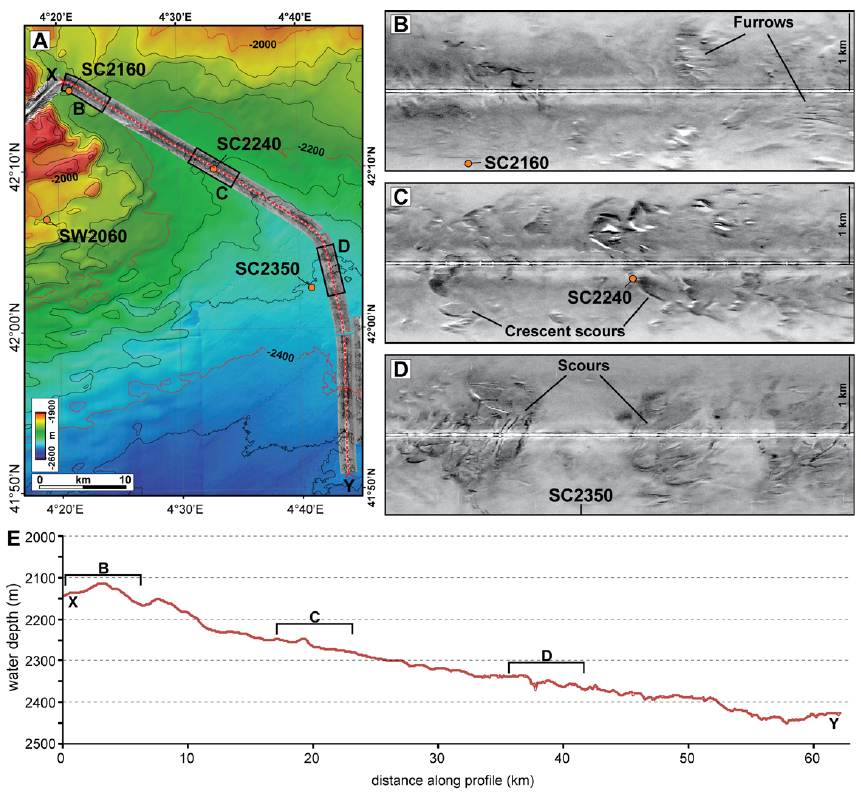
Fig. 10. Seabed morphology across the sediment wave field and along the S`ete Canyon distalmost reach, where the mooring sites are located (see Fig. 1). (A) Multibeam-derived bathymetry contour map, contours every 100m. Transect shown as dotted red line from X to Y . Note location of figures (B) , (C) and (D) along the section. (B) , (C) and (D) MAK-1M side-scan sonographs and (E) Bathymetric section along ( X – Y ). Sonographs are presented in inverse grey-scale (insonified areas are dark grey and black, whereas shadows are in white).